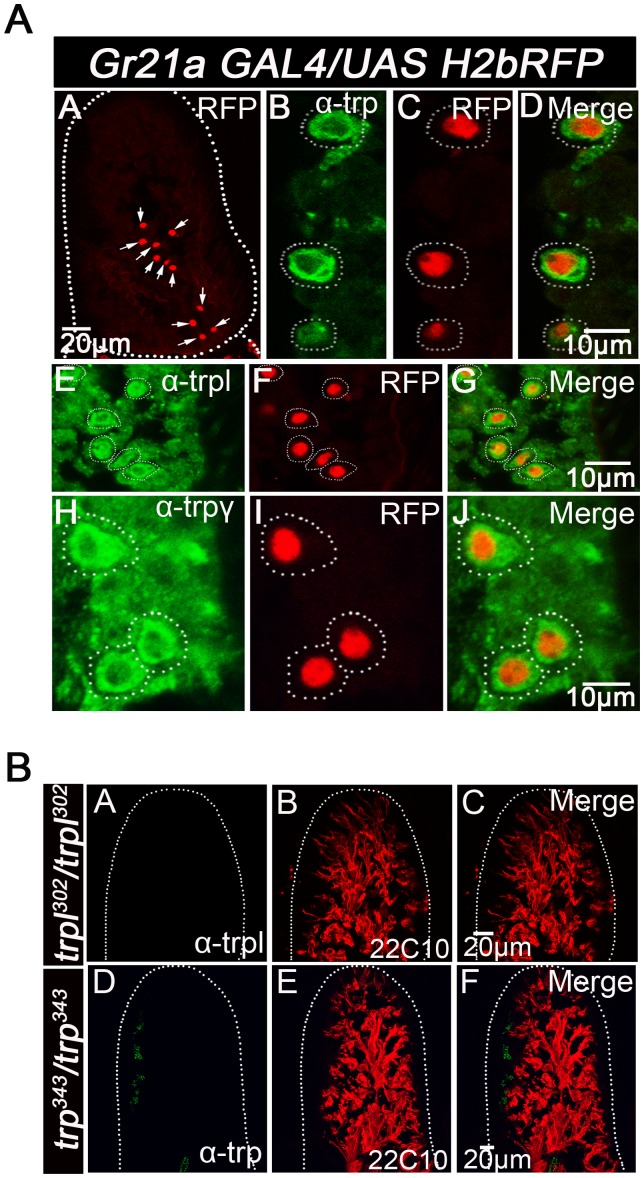
Expression of TRPC proteins in CO2 sensing neurons located in the third antennal segment of adult Drosophila.TRP, TRPL and TRPγ are expressed in CO2 responsive neurons in the adult Drosophila antenna. A) Frozen antennal sections (14 µm thick) from Gr21aGAL4/UASH2bRFP animals stained with anti-TRP, anti-TRPL and anti-TRPγ antibodies showing expression of TRP, TRPL and TRPγ respectively along the membranes of the Gr21a receptor neurons, marked by anti- RFP staining in red. The first panel shows the localization of Gr21a neurons in the antenna after staining with anti- RFP. B) Frozen antennal sections (14 µm thick) from the null mutants of trpl and trp stained with anti-TRPL and anti-TRP antibodies respectively. No expression of TRPL and TRP proteins could be observed in the respective mutant strains. mAb22C10 (anti-futch, microtubule protein) staining in red served as a neuronal marker.